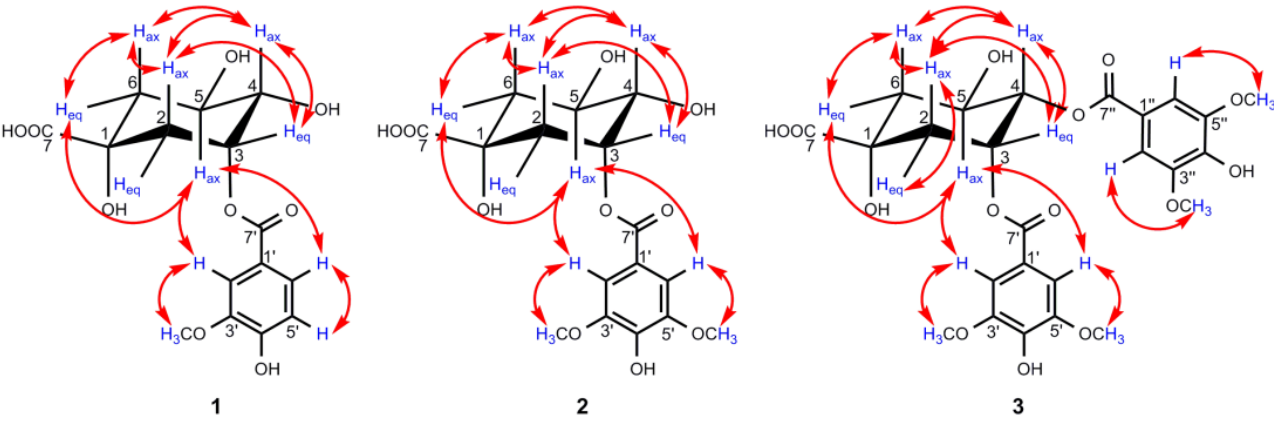
Figure 4. Key NOESY ( ↔ ) correlations of compounds 1 – 3 . In the HMBC spectrum, no correlation was observed between the oxygenated protons in the quinic acid moiety and the carbonyl carbon at δ C 167.9, so the vanilloyl group attached to C-3 was deduced by the downfield shift of H-3 ( δ H 5.50) according to the substituent chemical shifts effect [31], together with the NOESY correlations of H-5 ax /H-2